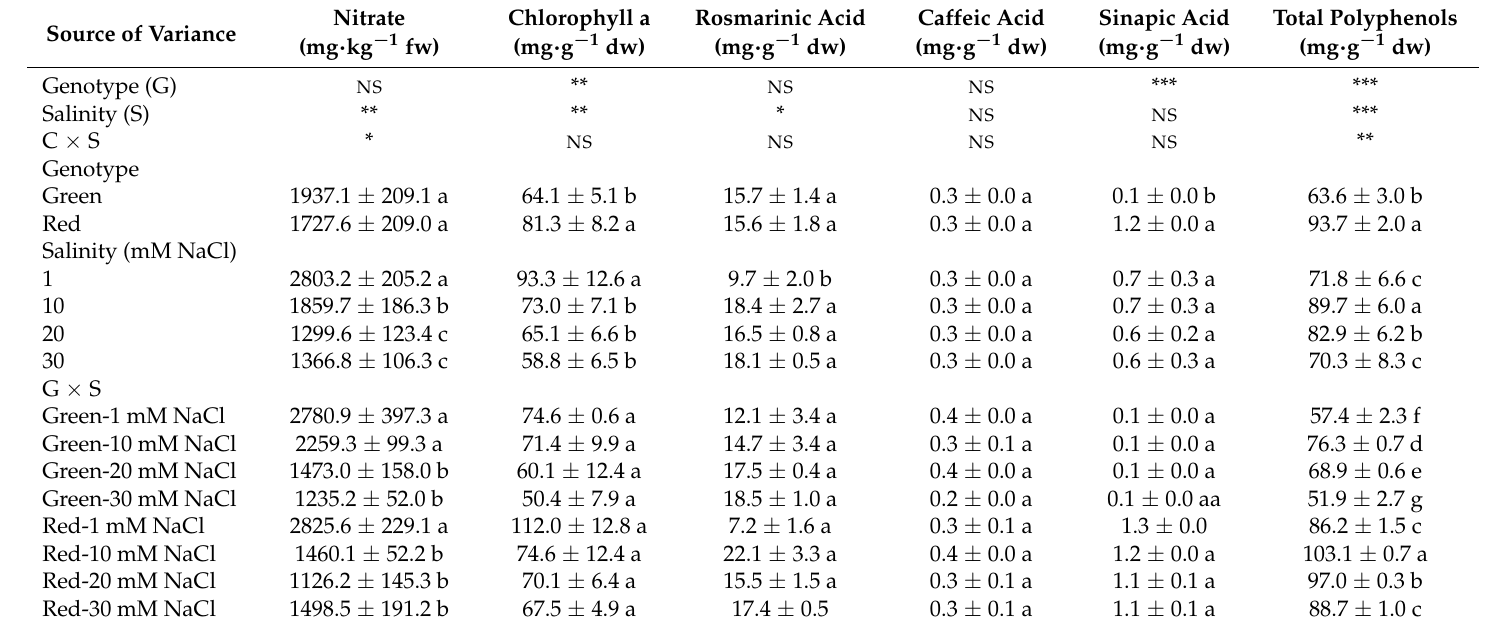
Table 3. Analysis of variance and mean comparisons for protein, nitrate and chlorophyll a contents, target phenolic acids and total polyphenols in green and red perilla grown under increasing NaCl concentration in the nutrient